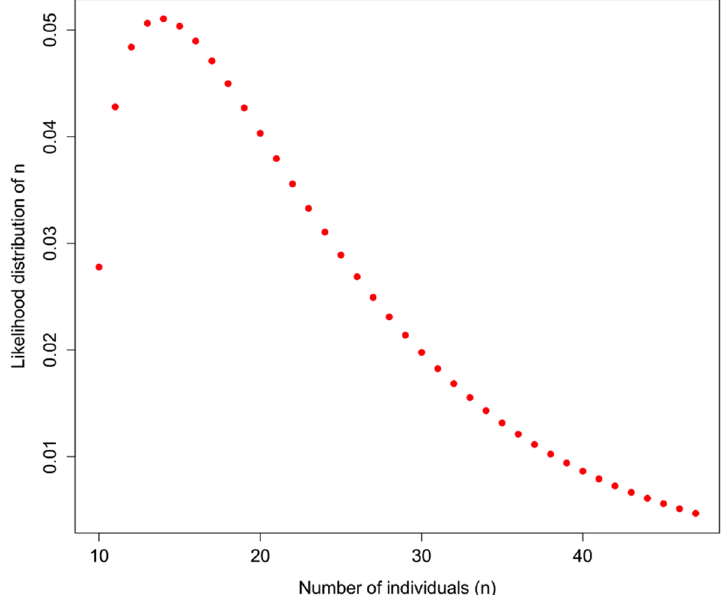
Figure 1. Likelihood of identifying n individuals in a sample in which 10 haplotypes are observed, and the haplotype diversity of the originally observed population is H = 0.7. Here, a gamma function is applied to represent the likelihood such that the distribution is flat at low values of H and a sharper distribution with high values of H , bounded by the actual observed number of haplotypes.